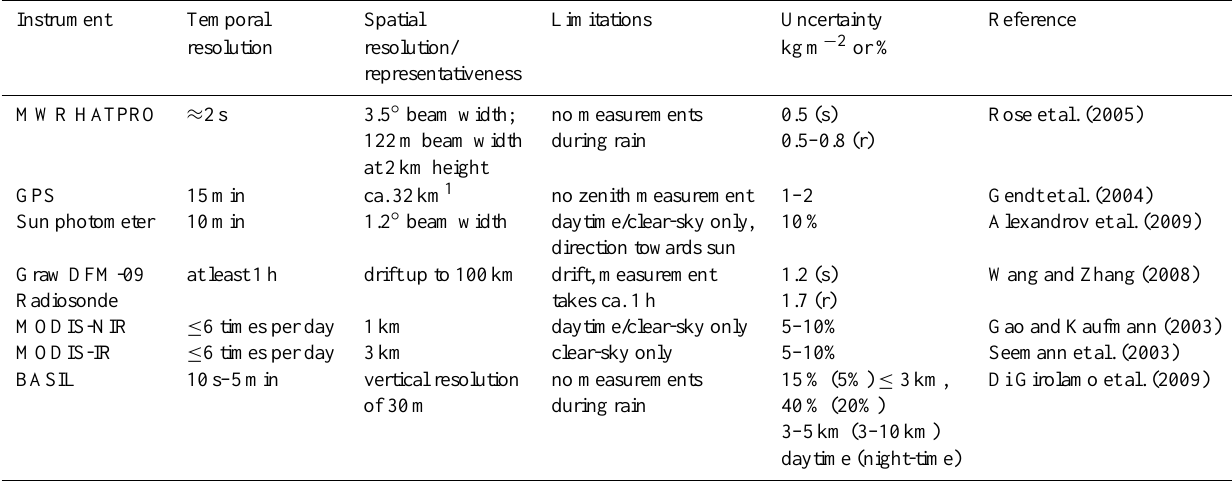
Table 1. Temporal resolution, spatial resolution or representativeness, limitations, and systematic (s), random (r) or combined error of measurements as found in literature for the instruments used in the present study.